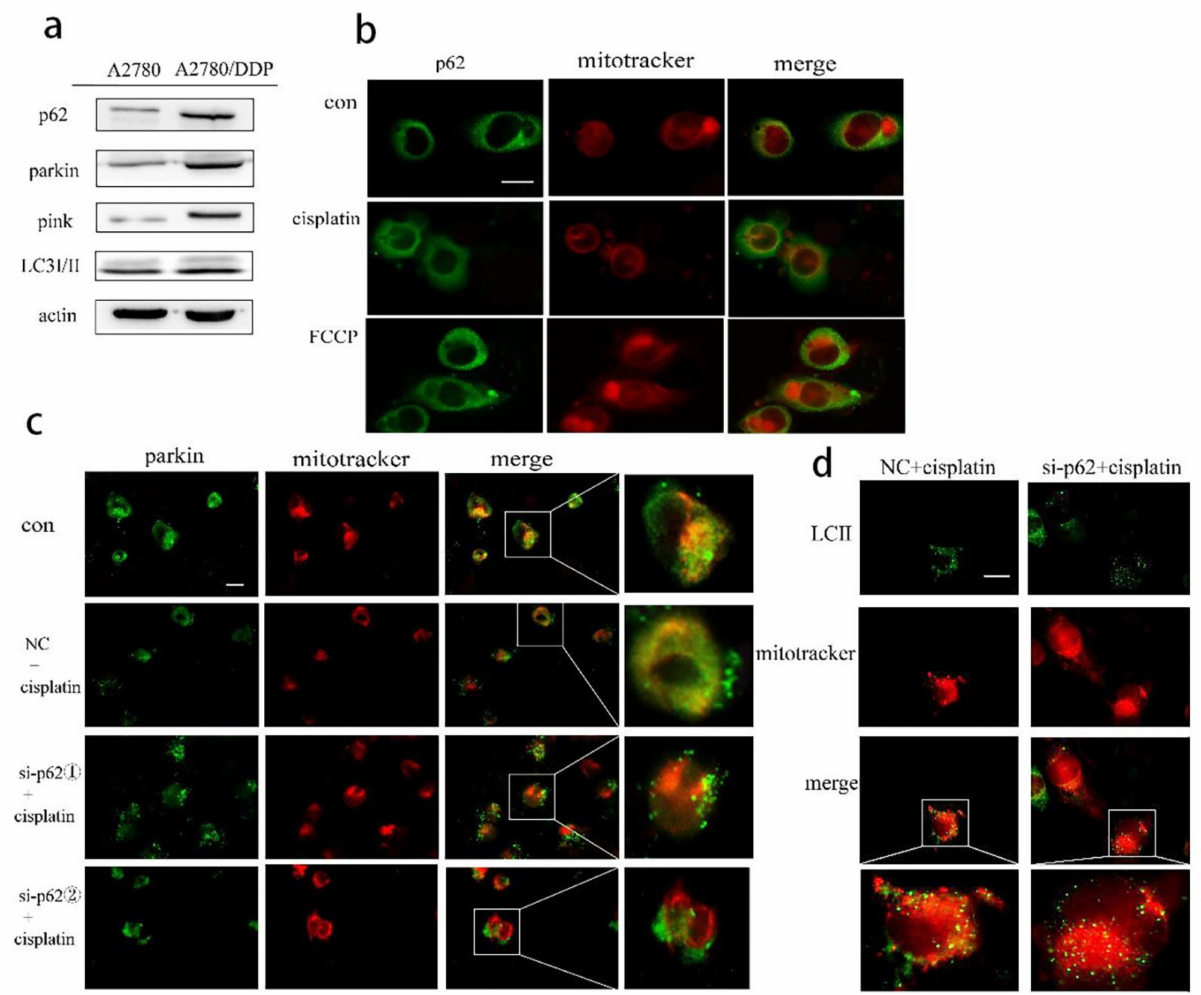
Figure 2. In ovarian cancer cells, p62 participates in parkin-mediated mitophagy stimulated by cisplatin. ( a ). Total proteins of A2780 and A2780/DDP cells were acquired, and the expression levels of p62, pink1, parkin and LC3 II/I were analysed by Western blot. ( b ). A2780/DDP cells were treated with cisplatin (20 µ g/mL) for 8 h. Localisation of p62 and mitotracker red was observed with fluorescence microscope. Scale bar, 10 µ m. ( c ). A2780/DDP cells transfected with si-p62. 1 (cid:13) or si-p62. 2 (cid:13) were treated with cisplatin (20 µ g/mL) for 8 h. Localisation of parkin and mitotracker red was observed with fluorescence microscope. Scale bar, 10 µ m. ( d ). A2780/DDP cells transfected with si-p62. 1 (cid:13) were treated with cisplatin (20 µ g/mL) for 8 h. Localisation of LC3II and mitotracker red was observed with fluorescence microscope. Scale bar, 10 µ